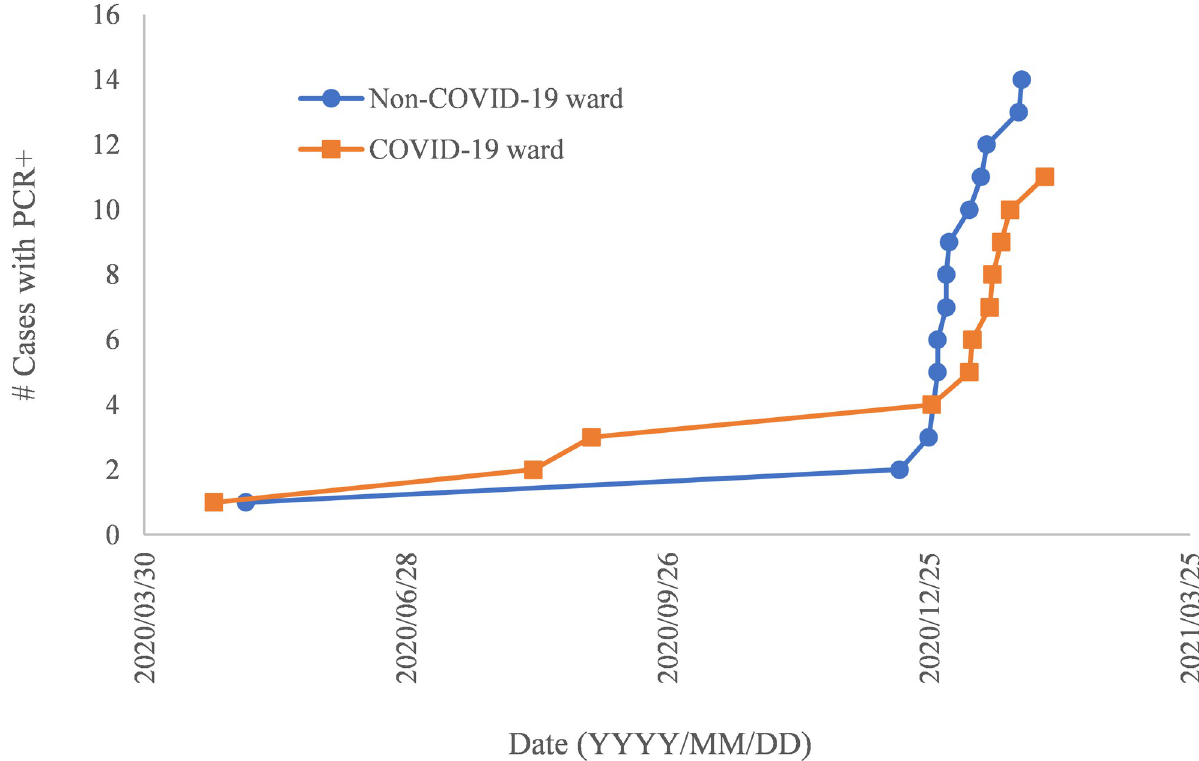
Fig 1. Accumulated number of cases with positive PCR results (y-axis) along with the confirmed timeline (x-axis). Blue circle, HCW’s in non- COVID-19 ward; orange square, HCW’s in COVID-19 ward.